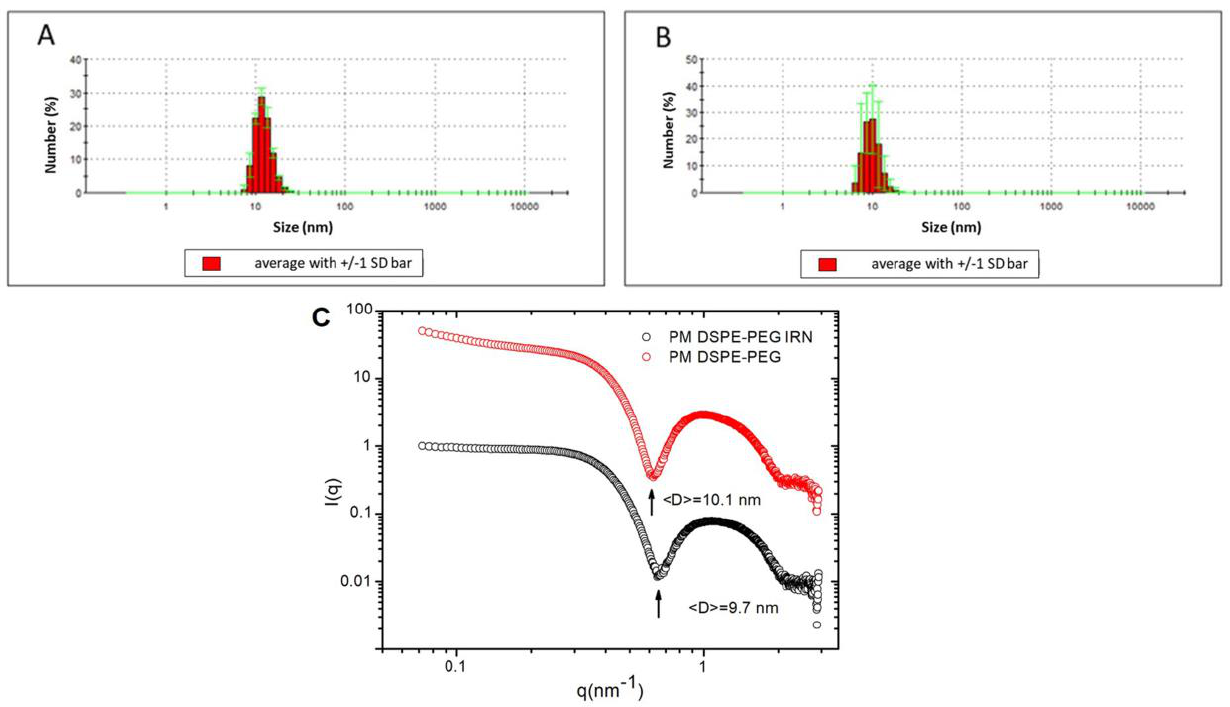
Figure 1. Size distribution for micellar formulations: ( A ) blank PM DSPE-PEG. Green bars represent SD of the mean values ( B ) PM DSPE-PEG IRN. Green bars represent SD of the mean values, and ( C ) SAXS pattern of PM DSPE-PEG and PM DSPE-PEG IRN. Black arrows correspond to the scattering vector condition (q).